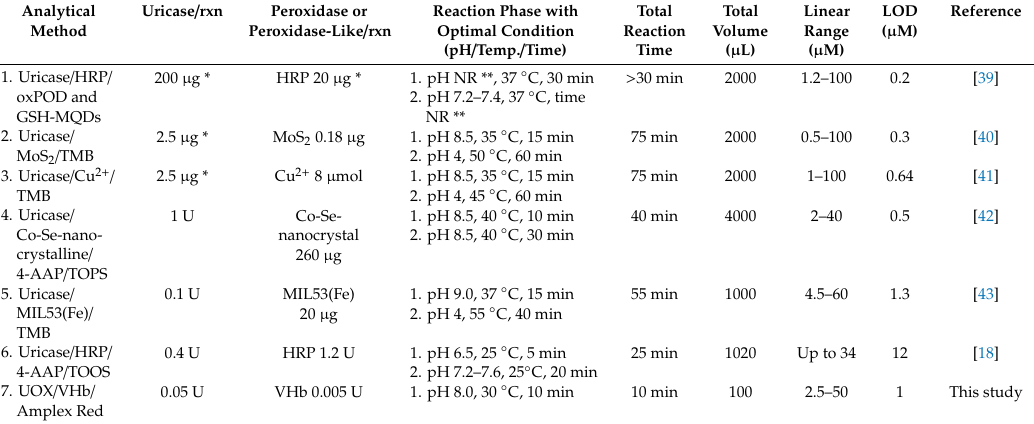
Figure 10. ( a ) Absorption spectra of the assay with di ff erent concentrations of uric acid (1–50 µ M) at a reaction time of 10 min. Photograph of the corresponding reactions is shown in the inset. ( b ) A dose-response curve between uric acid concentration and absorbance at 571 nm was constructed. Table 3. Comparison of di ff erent uricase-based colorimetric methods for detection of